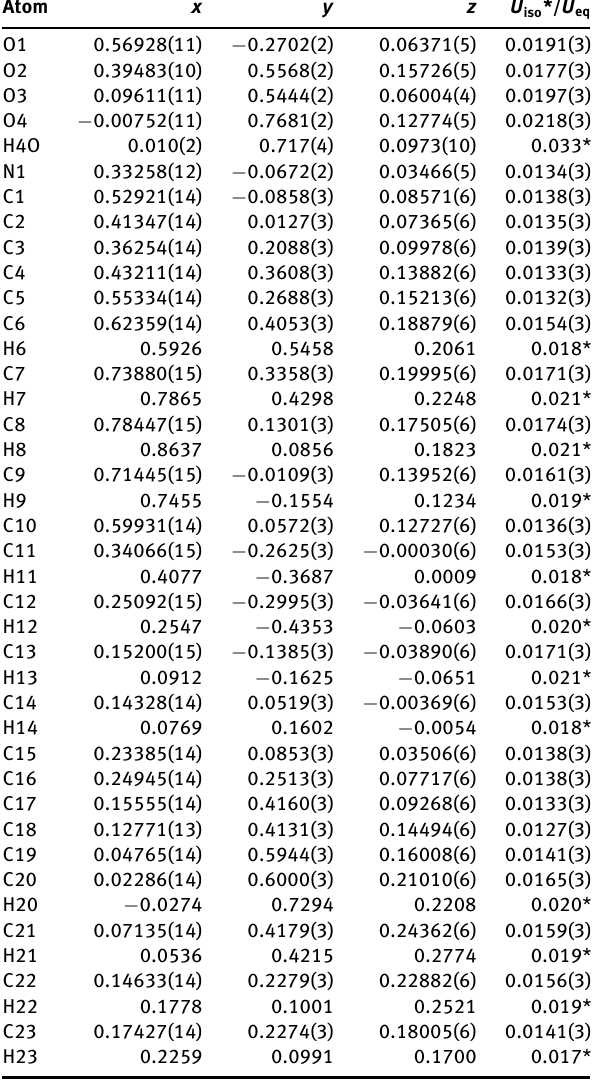
Table 2: Fractional atomic coordinates and isotropic or equivalent isotropic displacement parameters (Å 2